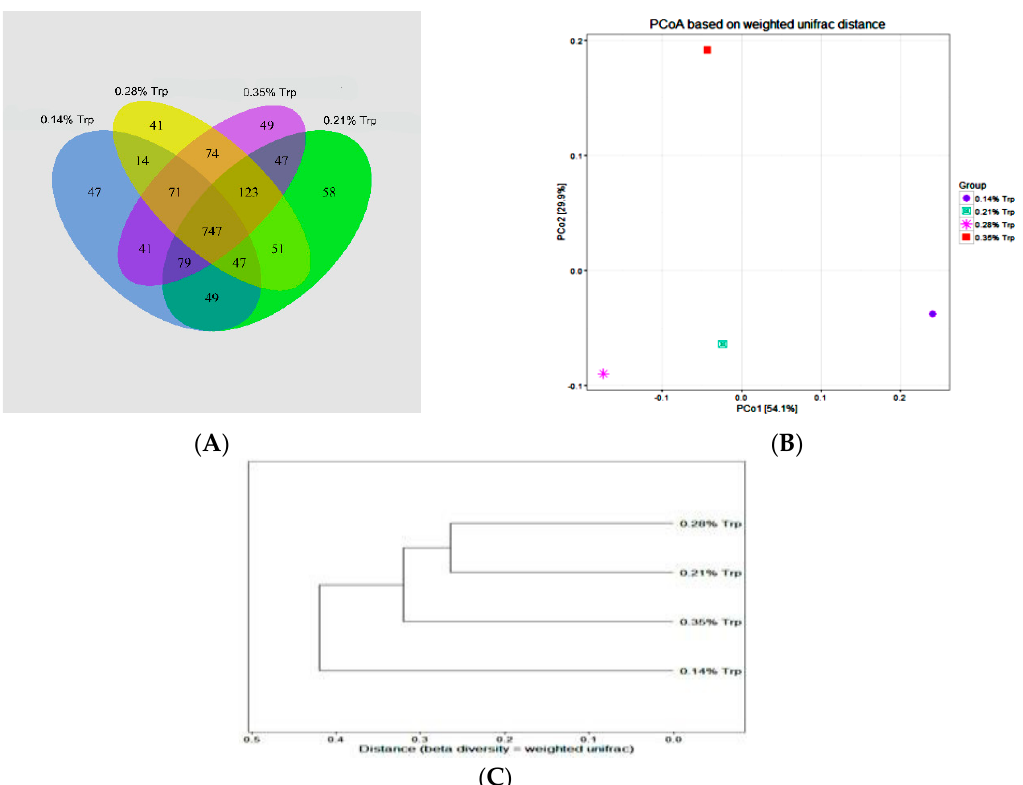
Figure 3. Effect of dietary tryptophan levels on the bacterial community in the colon of weaned piglets. ( A ) Venn diagram comparing the four groups. ( B ) The results of weighted UniFrac PCoA analysis. ( C ) The results of weighted UniFrac clustering analysis. Data are presented as the mean ( n = 5). Abbreviations: 1, the group supplemented with 0.14% tryptophan; 2, the group supplemented with 0.21% tryptophan; 3, the group supplemented with 0.28% tryptophan; 4, the group supplemented with 0.35% tryptophan.